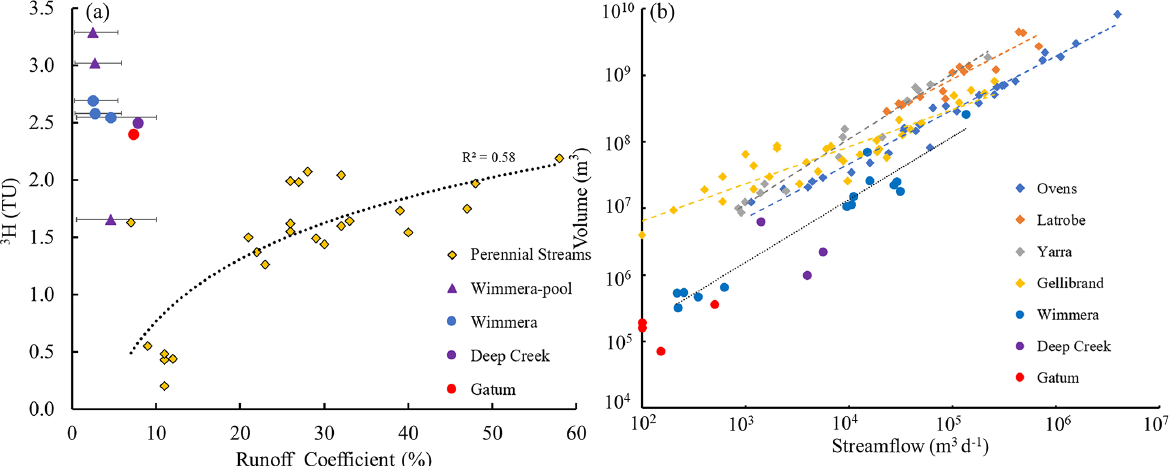
Figure 9. (a) Comparison of 3 H activities and runoff coefficients at low and zero flow conditions, and (b) volumes of water sustaining streamflows between the upper Wimmera River and other intermittent and perennial streams in southeast Australia. Error bars represent the uncertainty of annual rainfall in the upper Wimmera Catchment. Perennial streams are the Ovens, Latrobe, Yarra, and Gellibrand (data from Cartwright et al., 2020); intermittent streams are Deep Creek and Gatum (data from Cartwright and Morgenstern, 2016 and Barua et al.,